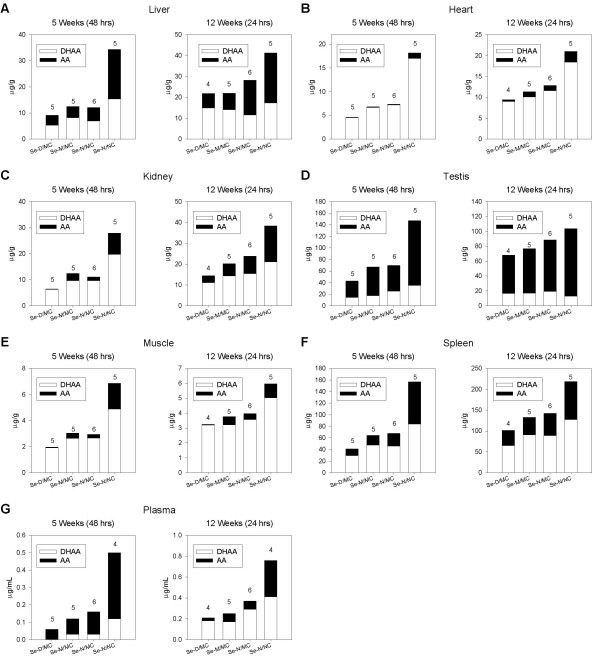
Vitamin C concentrations in tissues of guinea pigs fed the experimental diets. Bars signify the amount of total vitamin C (DHAA + AA) in tissues of guinea pigs fed the Se-D/MC, Se-M/MC, Se-N/MC or Se-N/NC diets. The proportions of DHAA (white portion of bar) and AA (black portion of bar) are shown. Values are reported as the mean. Number of tissues analysed for each diet group are indicated above the bars. For each tissue, data are shown for guinea pigs killed after 5 and 12 weeks on the experimental diets at 48 and 24 hrs post AA dosing, respectively.